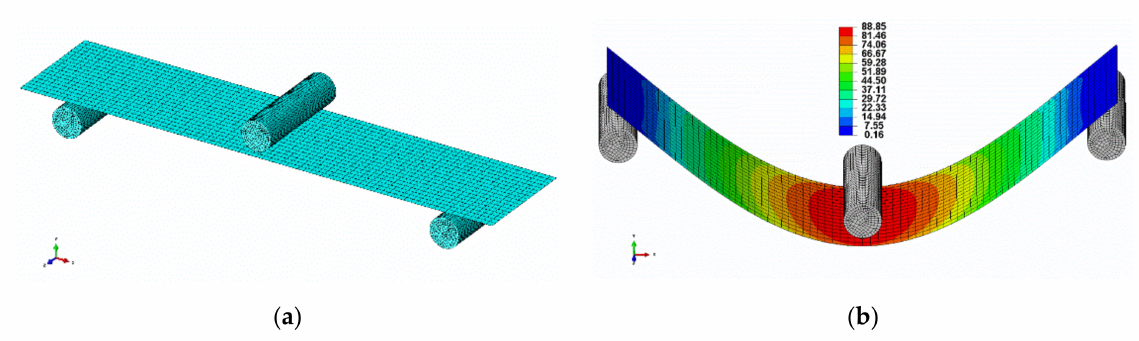
Figure 4. ( a ) FE model perspective of the bio-based composite sample and ( b ) the von Mises stress applied to the